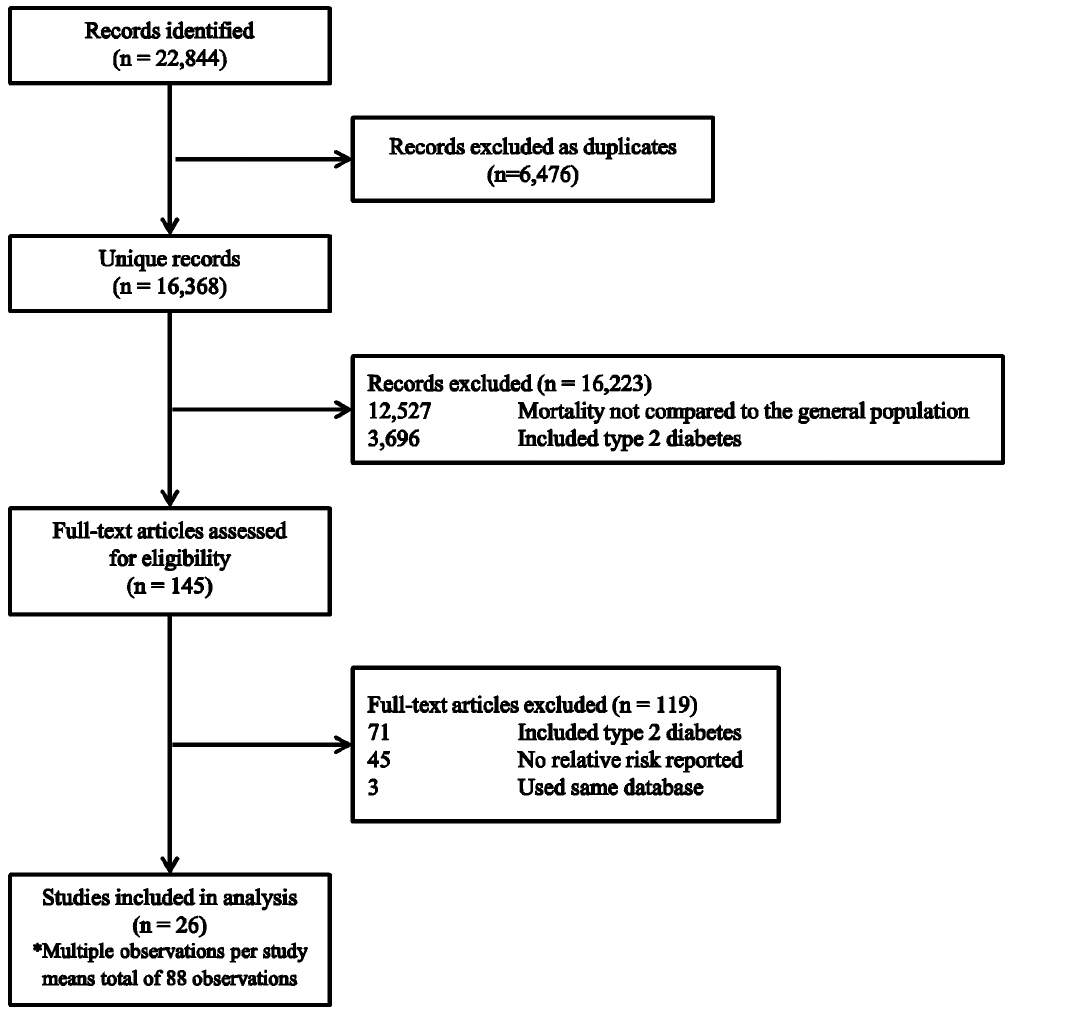
Figure 1. Flow chart of study selection